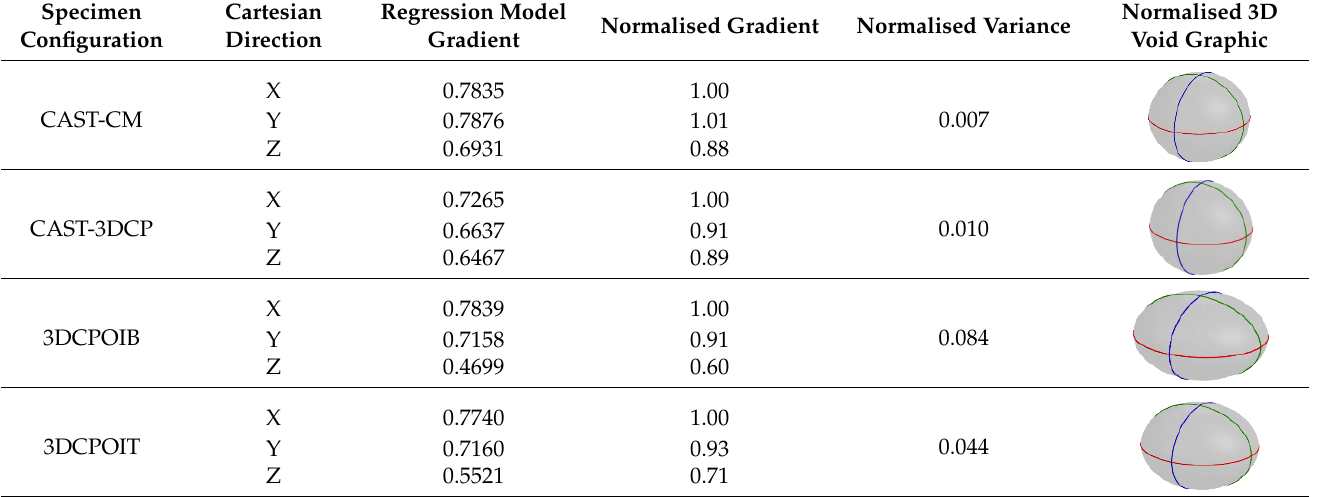
Figure 12. 3DCPOIT void topology from μ -CT scanning. The coefficients of determination (R 2 ) for x, y and z linear regression are 0.92, 0.91 and 0.86, respectively. Table 6. Normalised 3D voids for each configuration based on their regression model gradients. Normalisation performed with respect to the x-direction (printing direction).